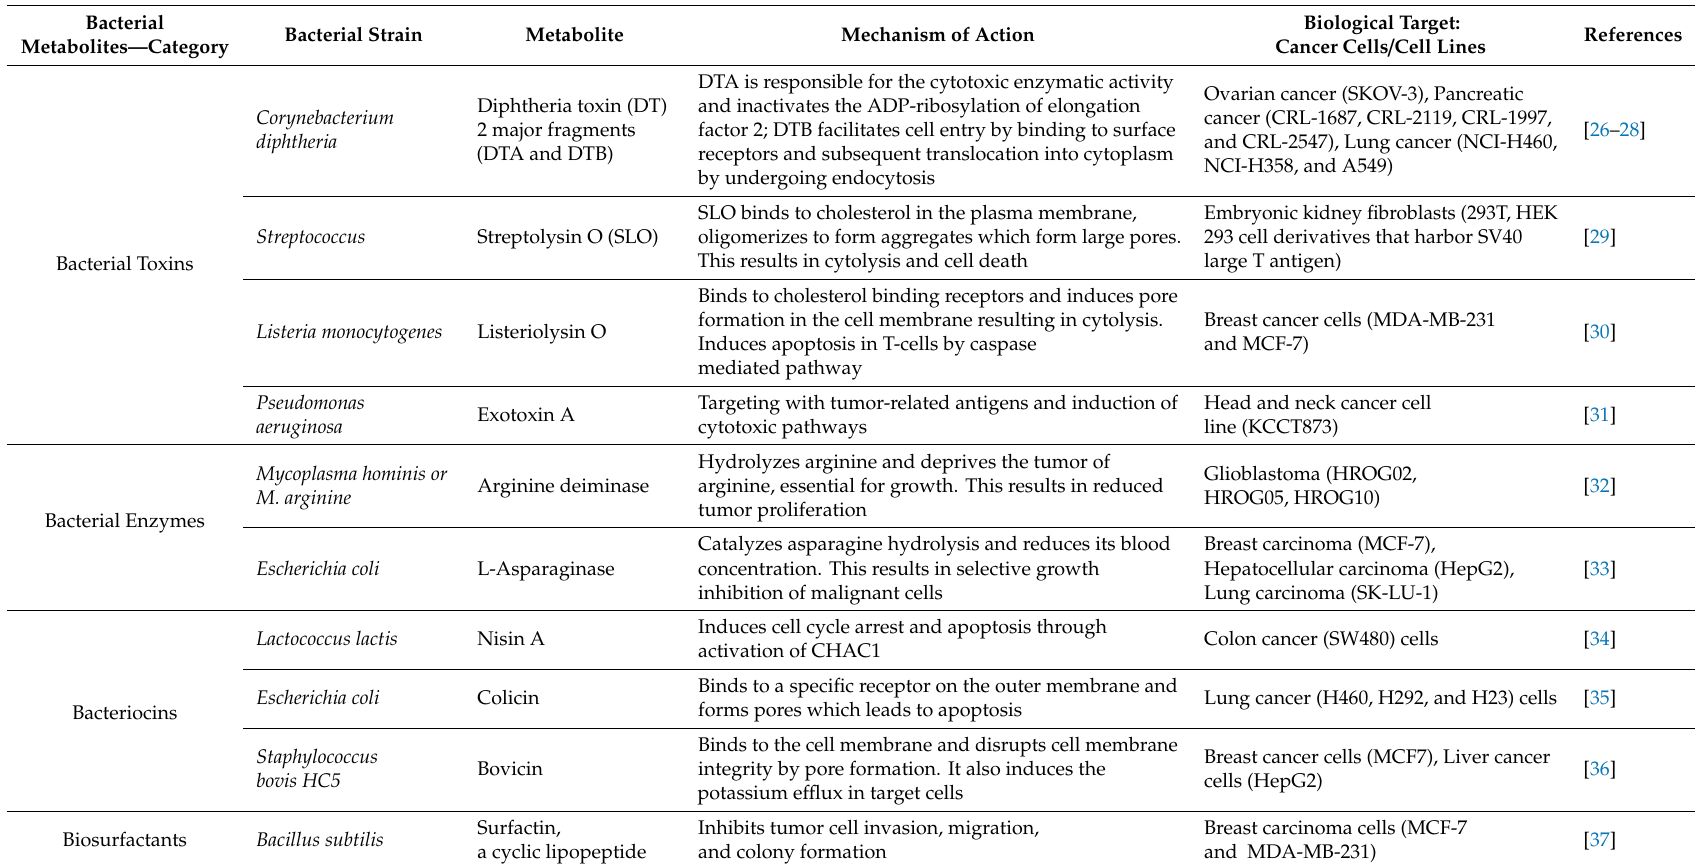
Table 1. Examples and anti-cancer mechanism of bacterial cell death inducing